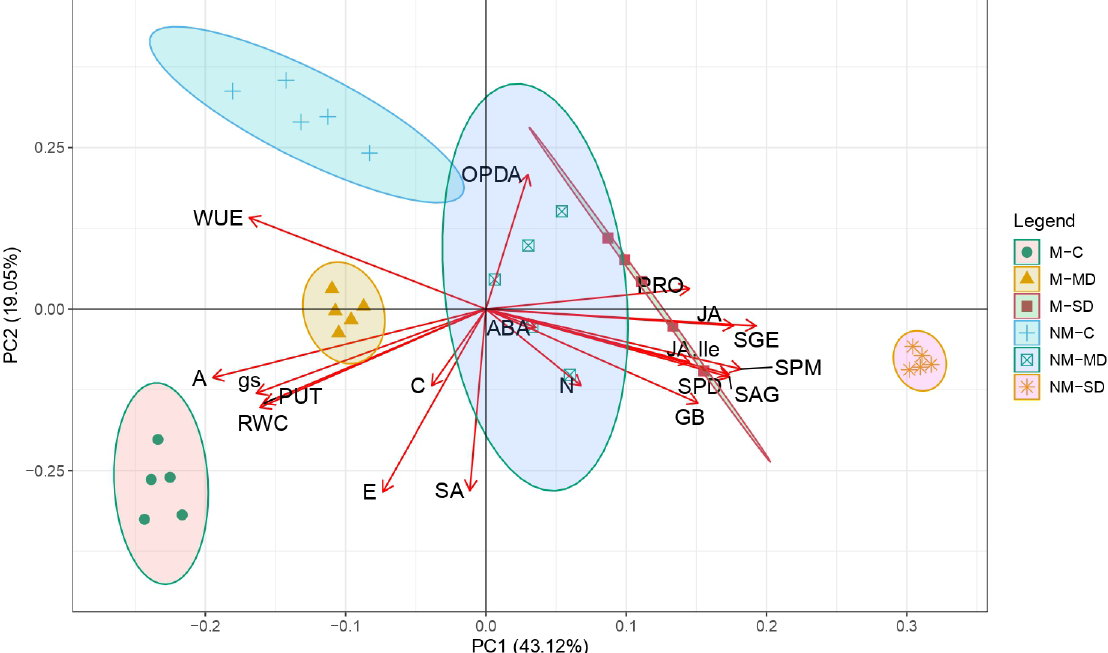
Figure 6. Loadings and the scores of examined treatments at the level of interaction for polyamines, plant hormones, compatible solutes, and physiological parameters for Q. robur for the first two prin- cipal components. C—control regularly watered oak seedlings, MD—oak seedlings exposed to the mild drought that corresponds with 60% of soil water field capacity, SD—oak seedlings exposed to the severe drought that corresponds with 30% of soil water field capacity ECM—oak seedlings in- oculated with ectomycorrhizal inoculum, and NM—oak seedlings not inoculated with ectomycor- rhizal inoculum.